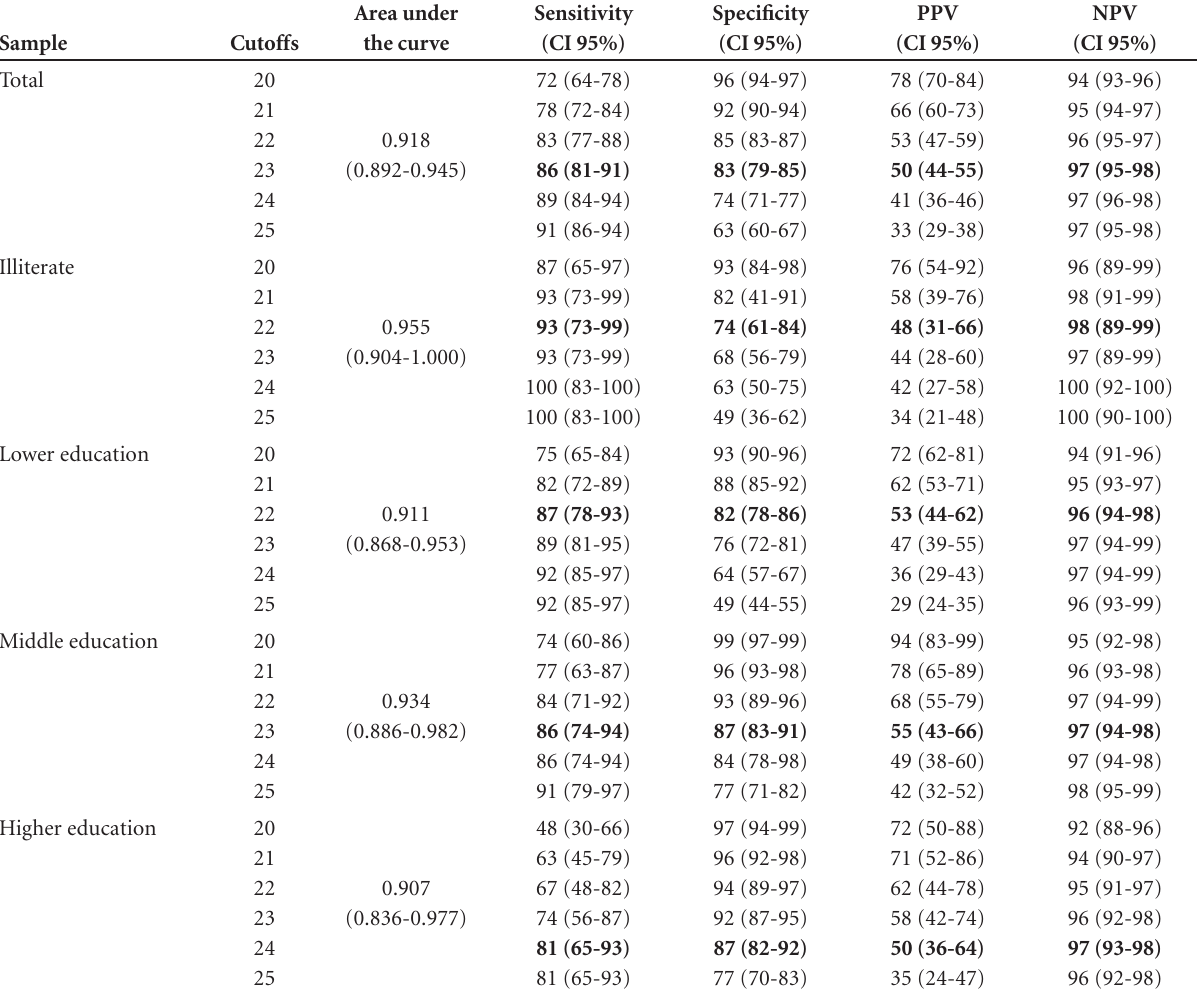
Table 2. Cut-off score on the Mini Mental State Examination obtained from coordinates of the ROC curve, and corresponding sensitivity, specificity, Positive Predictive Value (PPV) and Negative Predictive Value (NPV).